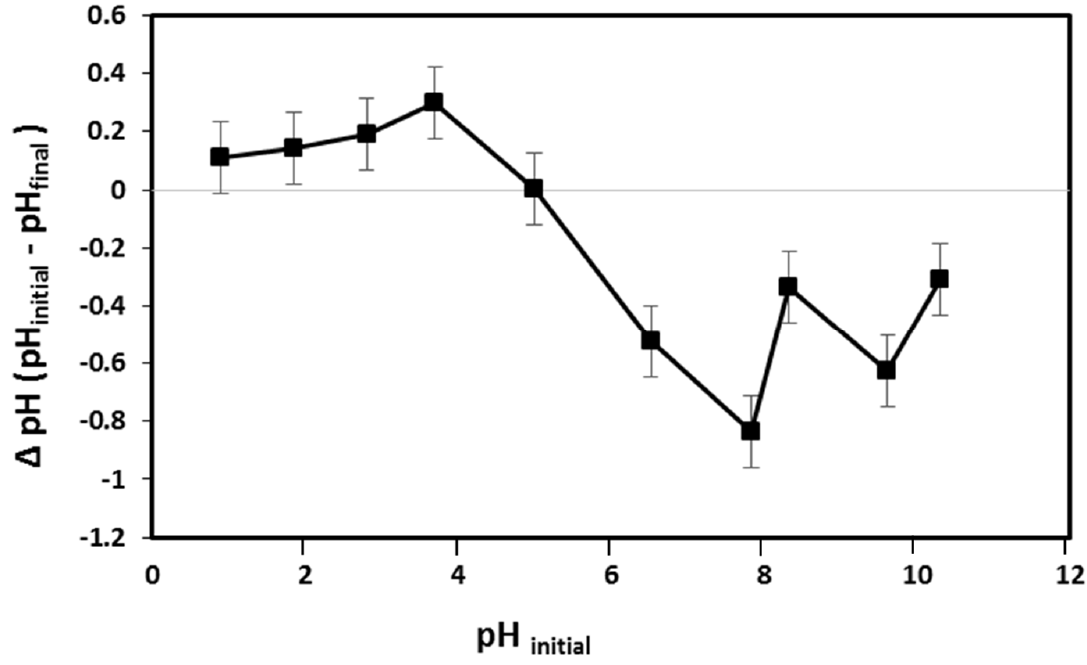
Figure 6. Determination of point zero charge (pH pzc ) of PVA-CS/CE composite hydrogel beads.